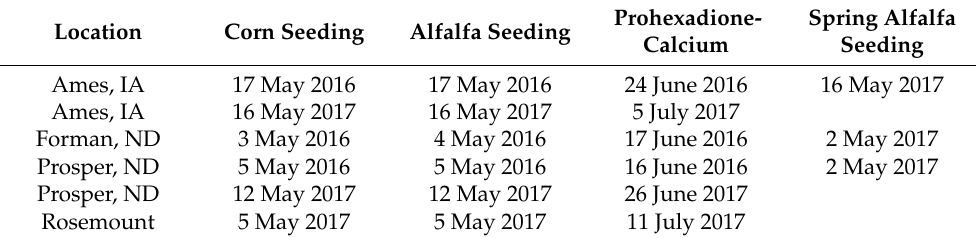
Table 2. Seeding dates and prohexadione-calcium application dates at all locations and